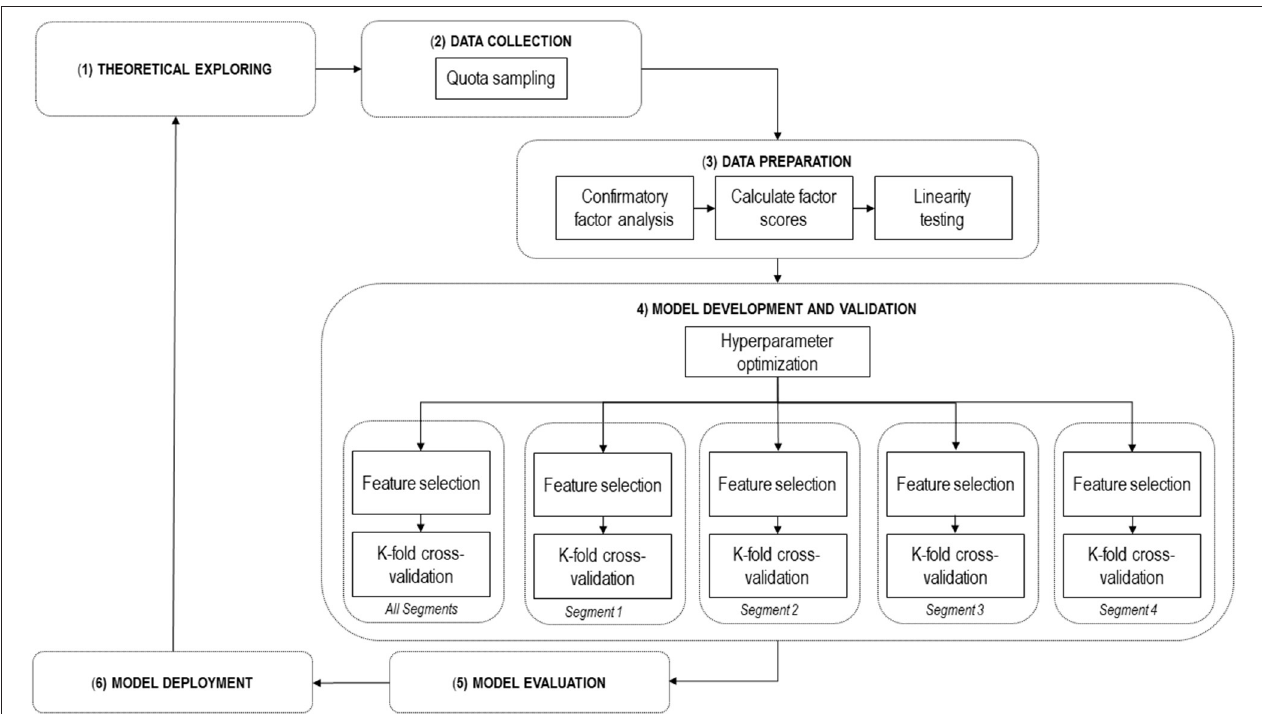
FIGURE 1 | Methodology